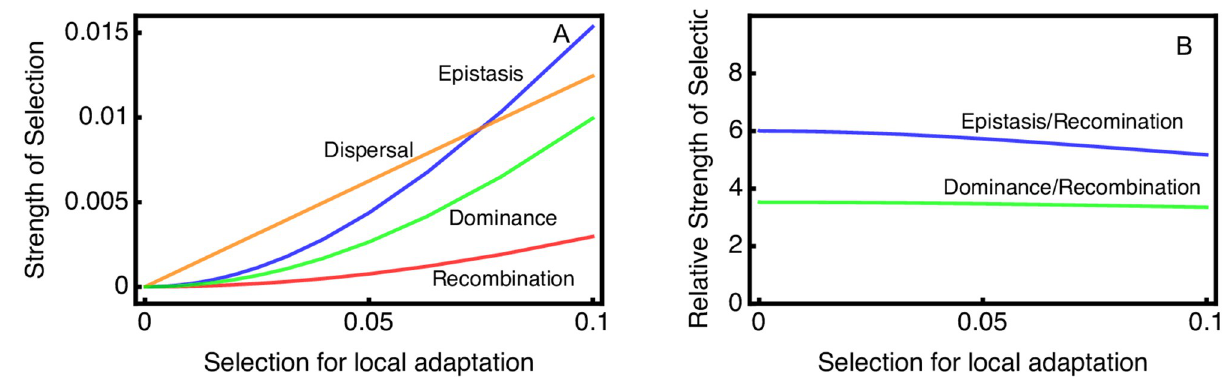
Fig 6. Selection for modifiers depends on the strength of selection for local adaptation. As the value of S is increased, the strength of selection on all types of modifier goes up (panel A). The relative advantage of epistasis and dominance modifiers, as compared with recombination modifiers, is shown in panel B. Epistasis modifiers have about a 6 fold higher invasion rate than a modifier that eliminates recombination (i.e. an inversion). Parameter values for the ancestral population are k = 3, M = 0.05, R = 0.5; ϕ = 0; θ =